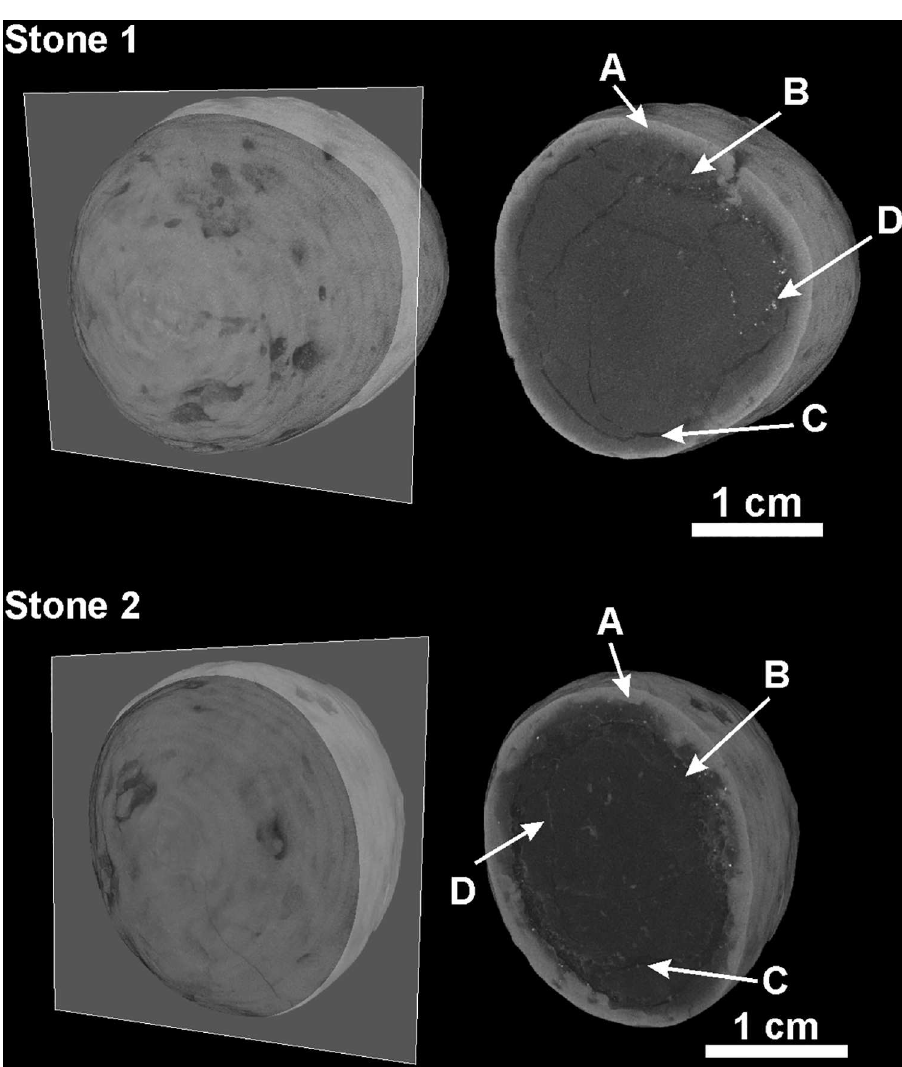
Fig 3. Internal structure. μ -CT reconstructed sections of stones S1 and S2: A: lighter grey colour, outermost portions; B: darker colour, innermost portions; C: black colour, fractures within the stone; D: light grey colour, calcite filling in some of the